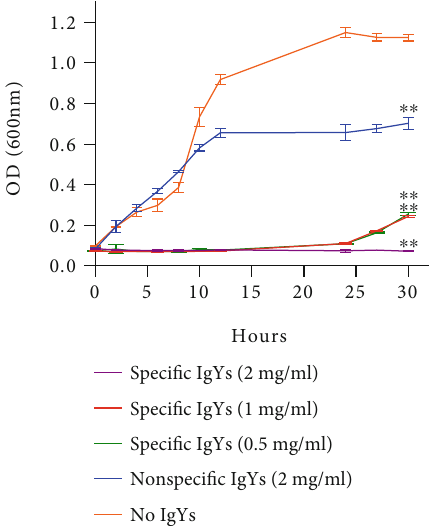
Figure 2: The growth inhibitory e ff ects of speci fi c anti- V. vulni fi cus IgYs as elicited with di ff erent antibody concentrations ∗∗ p < 0 : 01